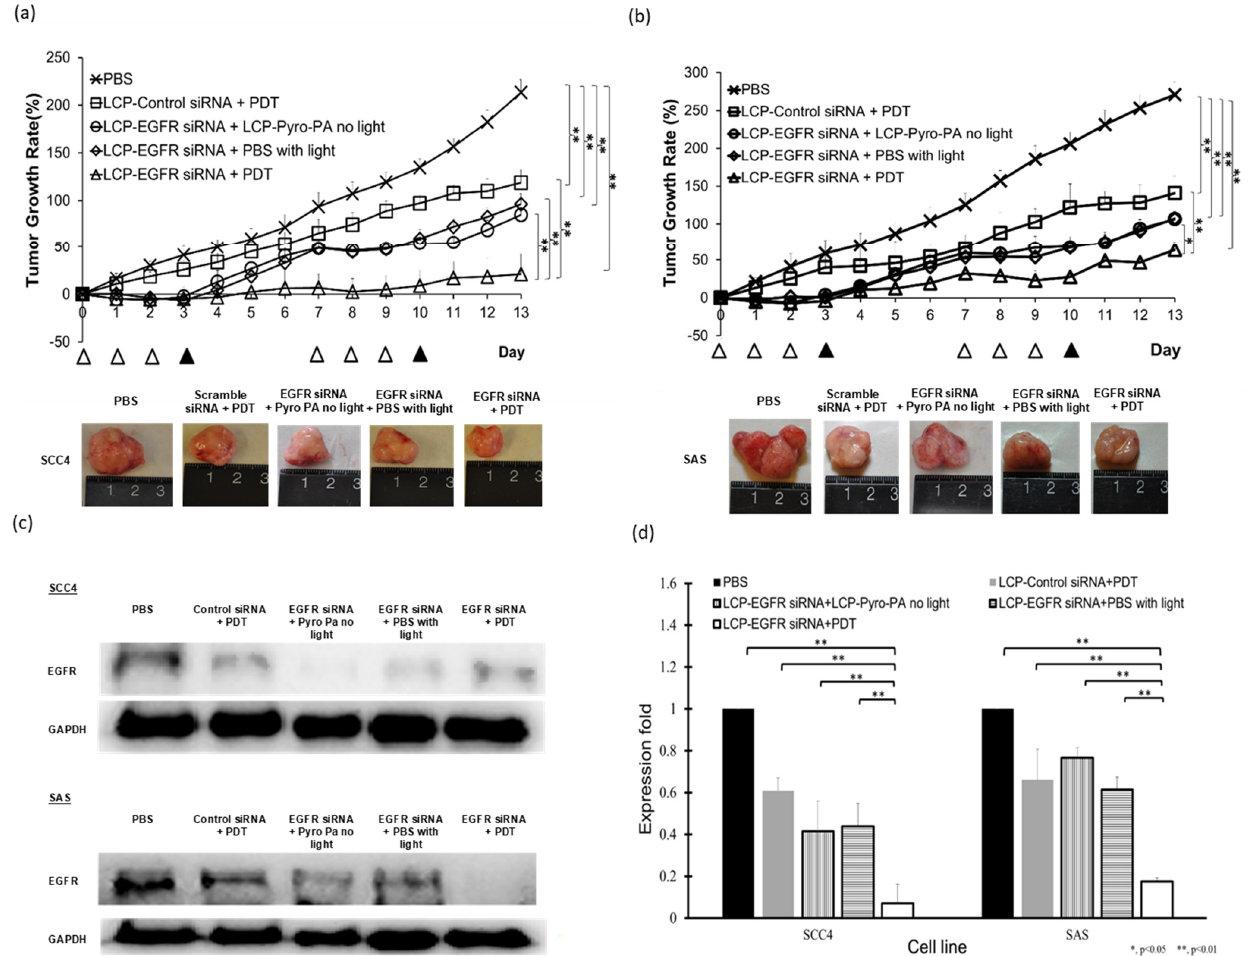
Figure 5. In vivo study of combined therapy. Tumor curves of SCC4 ( a ) and SAS ( b ) xenograft models. The experiments were conducted approximately 3–5 weeks post cell inoculation once the tumor volume reached approximately 200 mm 3 . △ indicated IV infusion of LCP with either Control siRNA or EGFR siRNA or PBS; ▲ indicated IV infusion of LCP Pyro PA with or without light. Tumor images of collected SCC4 ( a ) and SAS ( b ) xenograft tumors on day 13. ( c ) Quantified relative EGFR phosphorylated-EGFR (tyr1173) phosphorylated-EGFR (tyr1092) phosphorylated-EGFR (tyr1045), Her2, AKT, phosphorylated-AKT, cleaved caspase-3 and GAPDH protein expression band intensity in SCC4 and SAS cell line. ( d ) QPCR analysis of EGFR protein expression after treatment for SCC4 and SAS xenograft model. Quantified relative EGFR protein expression normalized against GAPDH. GAPDH protein was applied as the internal normalized protein marker with their respective relative EGFR protein expression. Columns, mean ( n = 3); *, p < 0.05; **, p < 0.01.